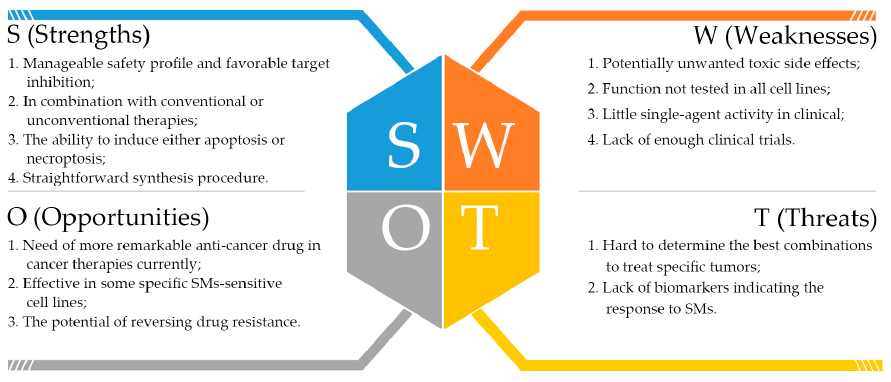
Figure 4. The Strengths, Weaknesses, Opportunities, and Threats (SWOT) analysis of SMs from our point of view.